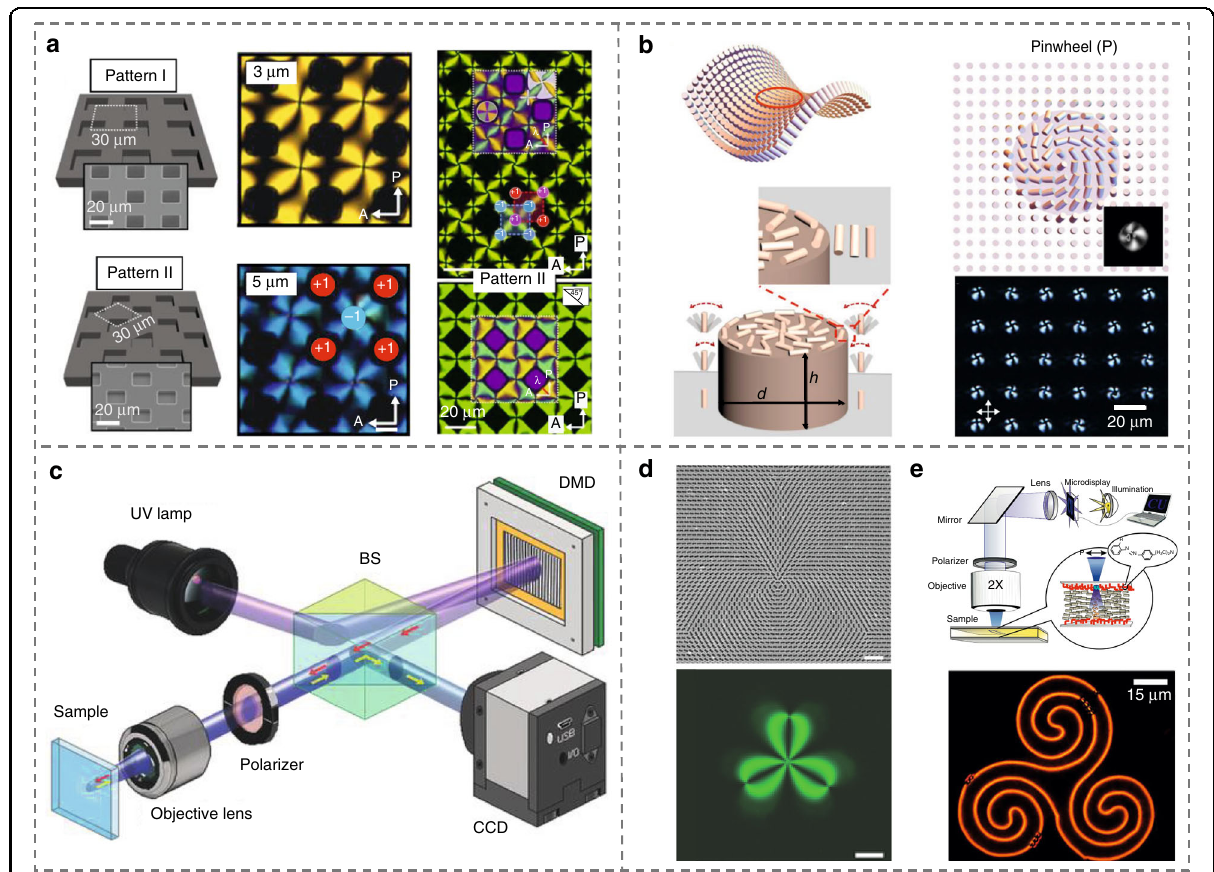
Fig. 2 Patterned nematic structures by 3D topographic and photoaligned substrates. a Topological defect arrays controlled by patterned air pillars 65 . Adapted from ref. 65 , with permission from AAAS. b Topographically and chemically patterned saddle-splay microstructures 66 . Reproduced from ref. 66 , with permission from Springer Nature: Nature Communications. c - e Photopatterning of NLCs enabled by DMD-based micro-lithography setup 67 , plasmonic metamask 72 , and functional azobenzene-containing surface monolayers 73 , respectively. Reproduced from ref. 67 , with permission from Wiley-VCH. Reproduced from ref. 72 , with permission from Wiley-VCH 73 . Reproduced from ref. 73 , with permission from National Academy